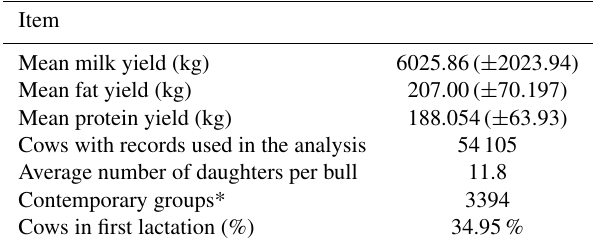
Table 1. Characteristics of data used in the analysis.